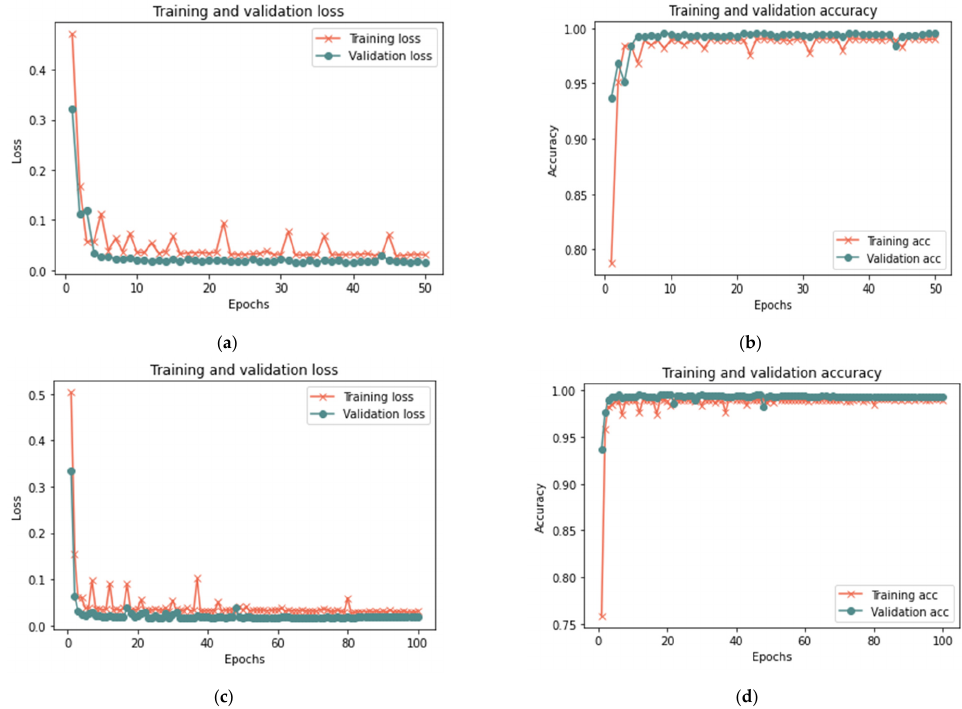
Figure 18. Results of the third scenario with 100% sample size: ( a ) loss at 50 iterations; ( b ) accuracy at 50 iterations; ( c ) loss at 100 iterations; and ( d ) accuracy at 100 iterations.